Question: Which kind of chart has been used to present this data?
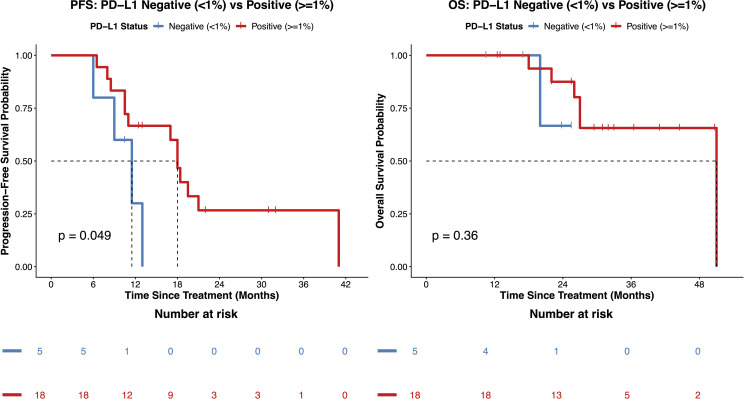
Answer: survival